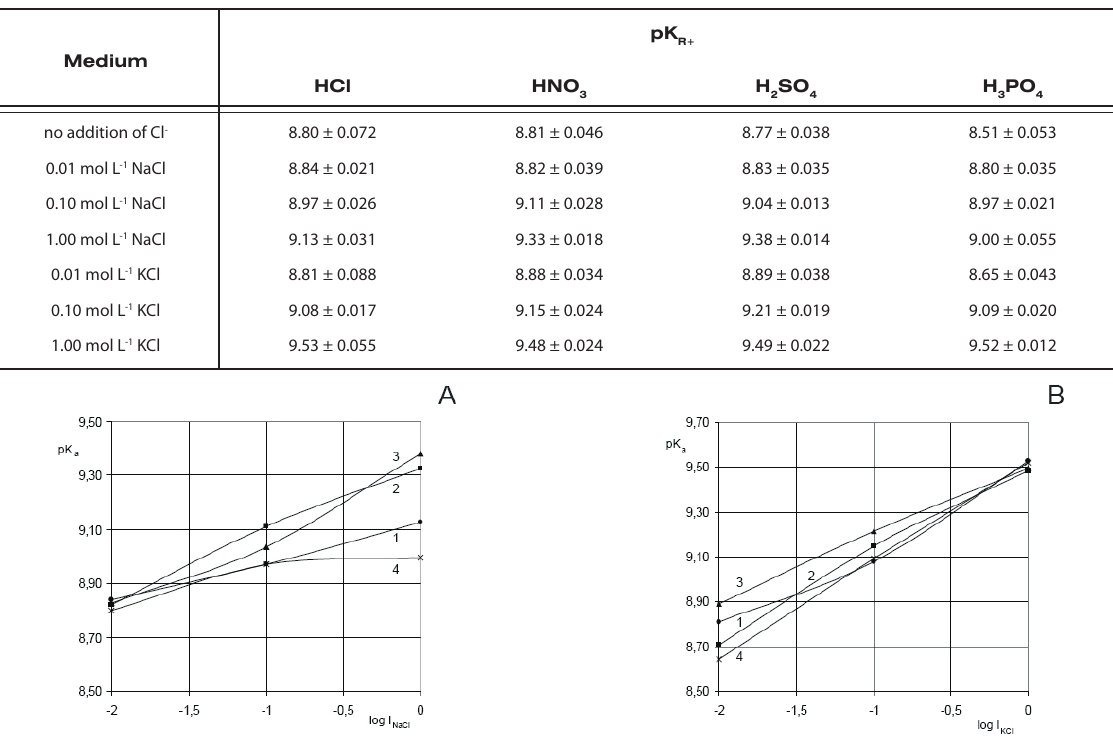
Table 5. Values of pK of chelerythrine in dependence on the type and concentration of inert electrolyte (ionic strength - as NaCl or KCl additions) R+ calculated using a numerical interpretation of the A-pH curves by a SQUAD-G program (c adjusted by NaOH).